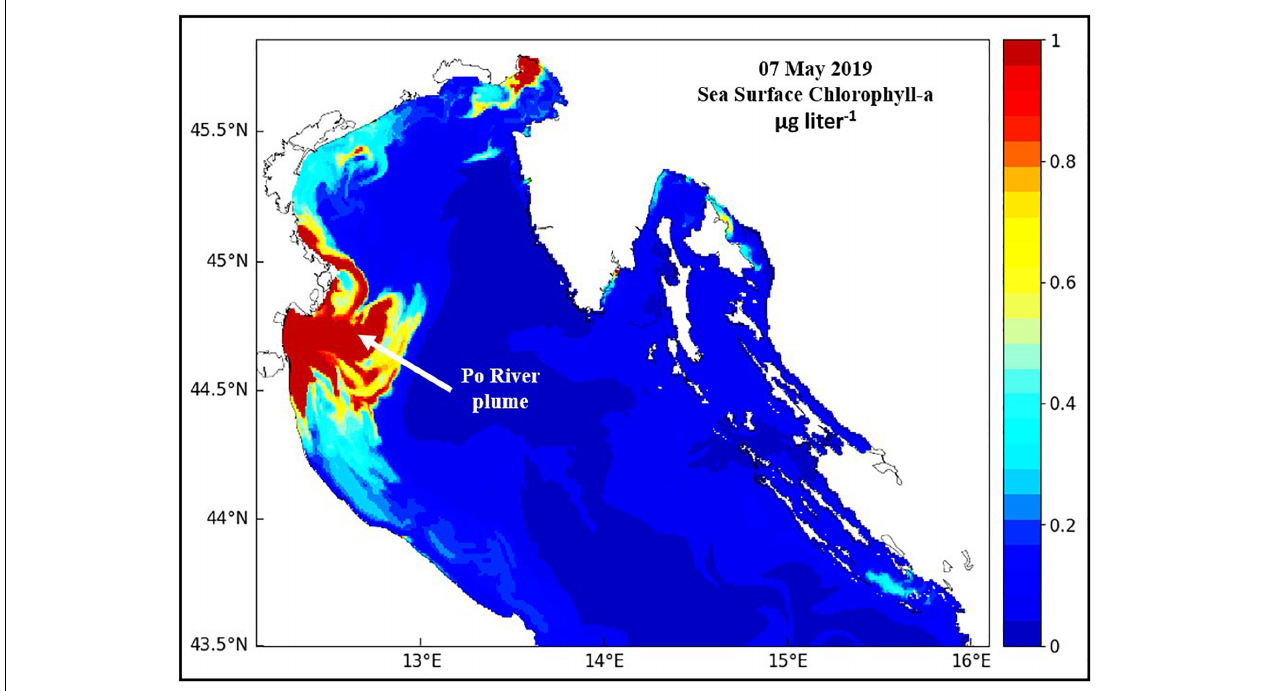
FIGURE 7 | The high phytoplankton biomass (red – high, blue – low) footprint of the coastal plume of the Po River in the northern Adriatic Sea.